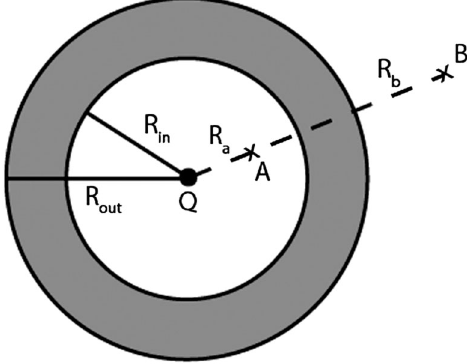
FIG. 4. A thick conducting shell surrounding a charged